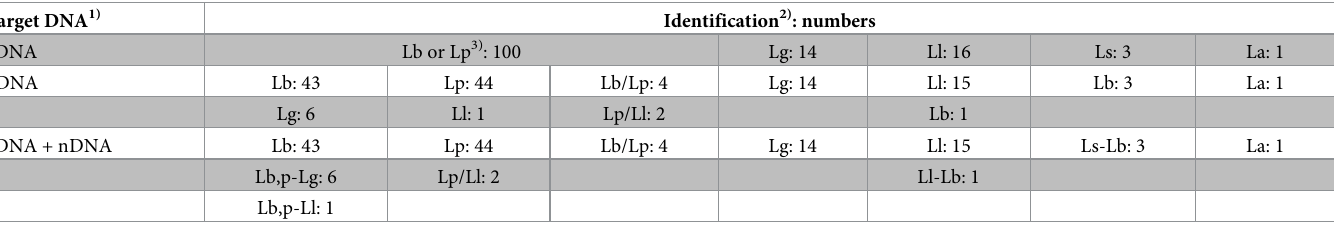
Table 2. Comparison of Leishmania species identification in Peru targeting kinetoplast and nuclear DNAs. Target DNA